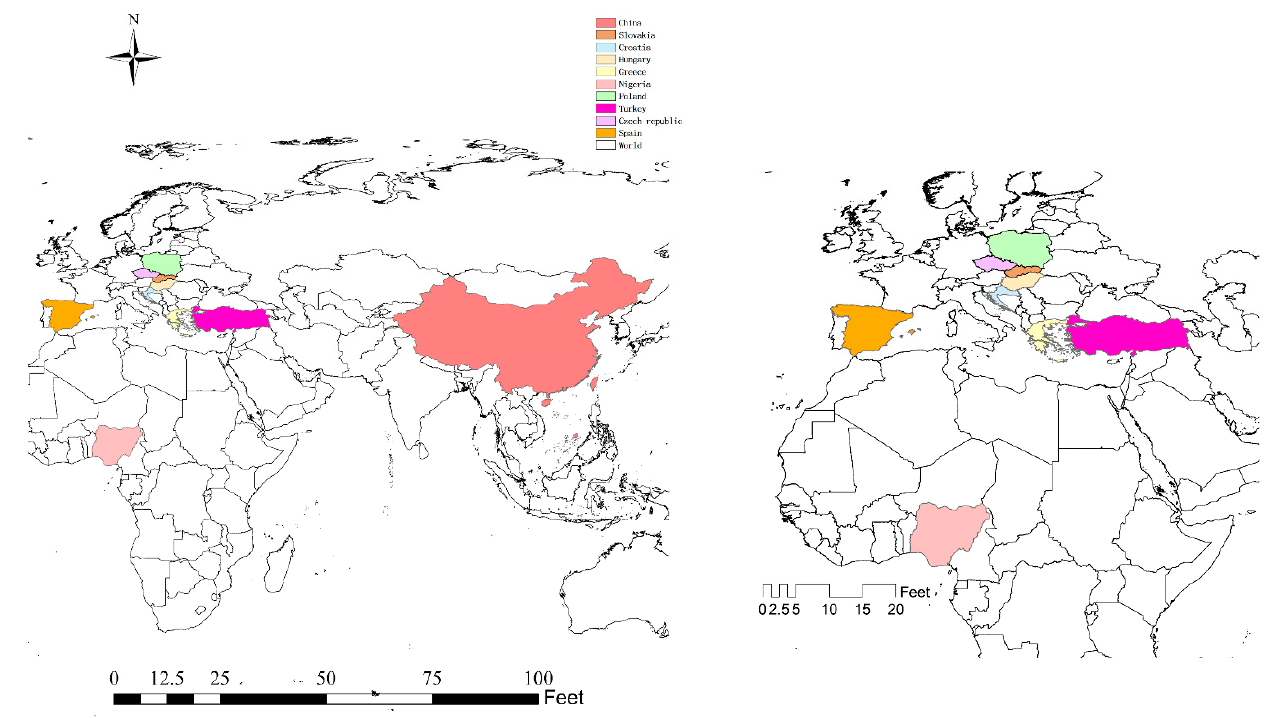
Figure 3. Geographical distribution map of countries covered.